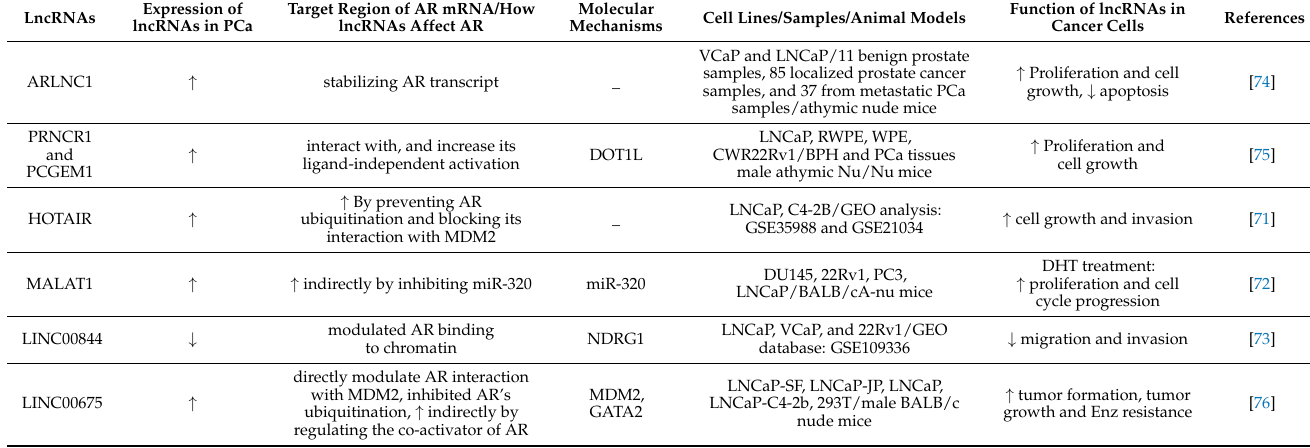
Table 3. Effects of different lncRNAs on AR in prostate cancer (ANCT: PCa: prostate cancer, DHT: dihydrotestosterone, CRPC: castration-resistant prostate cancer, ADPC: androgen-dependent prostate cancer, AD: androgen deprivation, DIM: 3,3 (cid:48) -Diindolylmethane, SAM: Synergistic activation mediator, LBD: ligand-binding domain, ↓ : decrease in, ↑ : increase in). LncRNAs Expression of lncRNAs in PCa VCaP and LNCaP/11 benign prostate ↑ Proliferation and cell samples, 85 localized prostate cancer stabilizing AR transcript _ samples, and 37 from metastatic PCa growth, ↓ samples/athymic nude mice